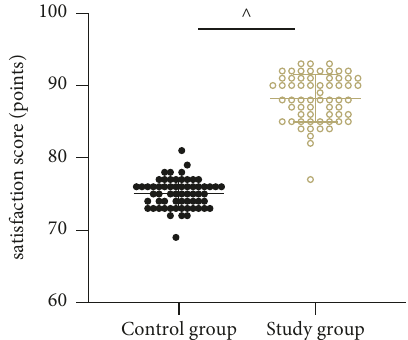
Figure 4: Comparison of the duration of postoperative bowel movements within the two groups (min). ^ represents a significant difference between the two groups.